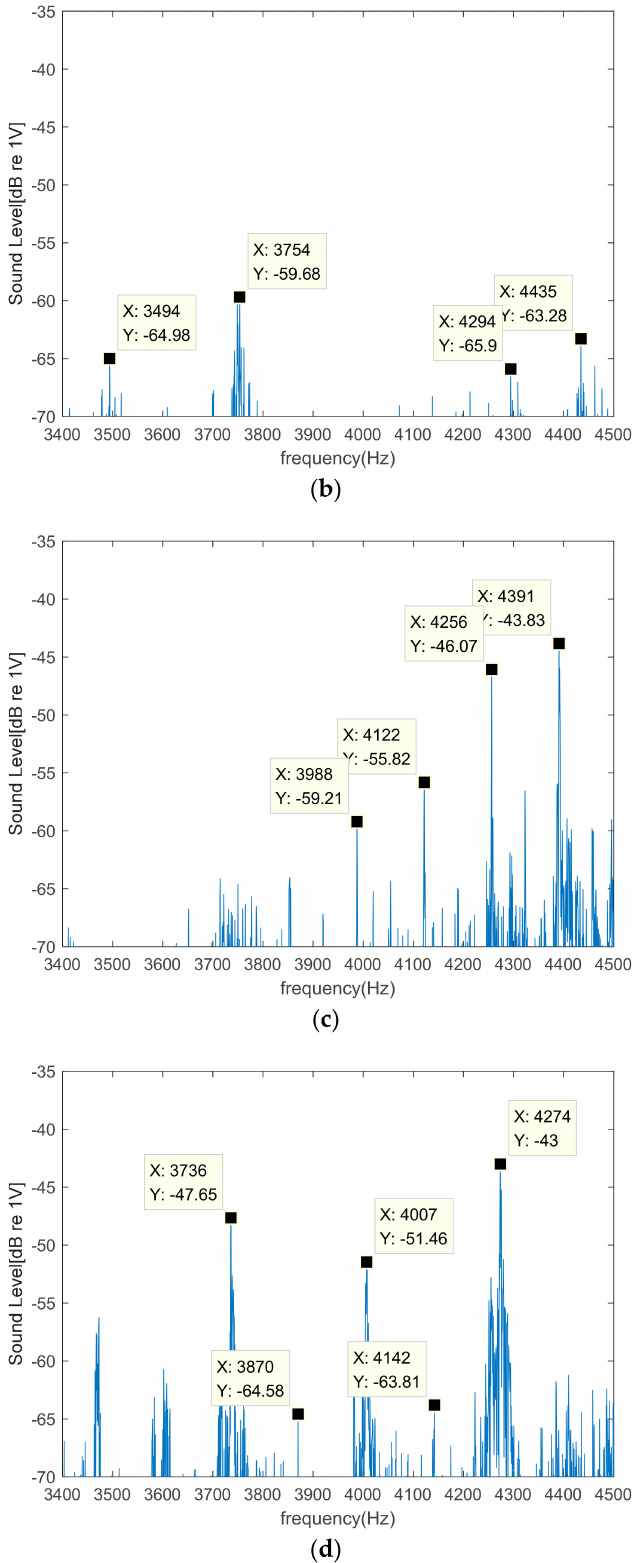
Figure 4. The CNC milling chatter circumstances are detected at a high frequency between 3.4–4.5 kHz ( a ) resonance frequencies of data1; ( b ) resonance frequencies of data2; ( c ) resonance frequencies of data2; ( d ) resonance frequencies of